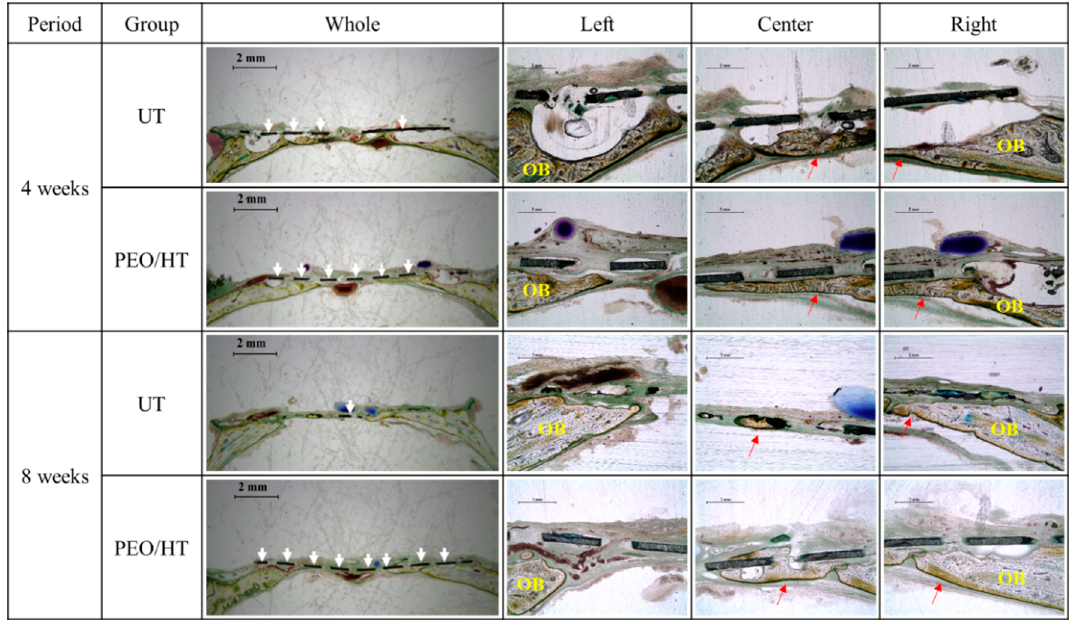
Figure 7. Histological images for bone regeneration in the rat calvarial defect after four weeks and eight weeks of implantation. (Red arrows = newly formed bone; yellow-OB = old bone; white arrows = magnesium mesh).